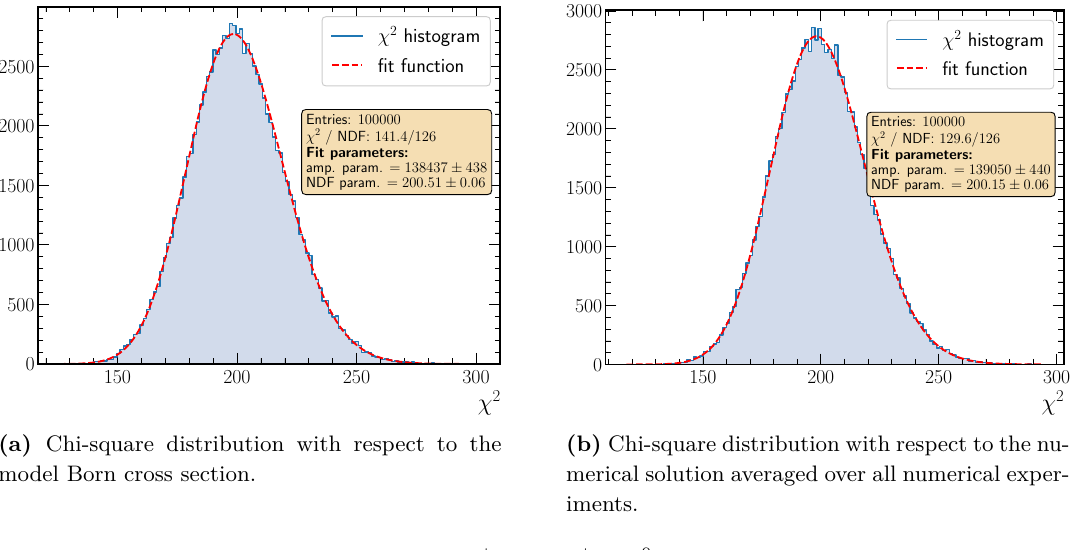
Figure 9. Chi-square distribution for the e + e − → π + π − π 0 Born cross section obtained using the naive method. The numerical solution is obtained using mixed